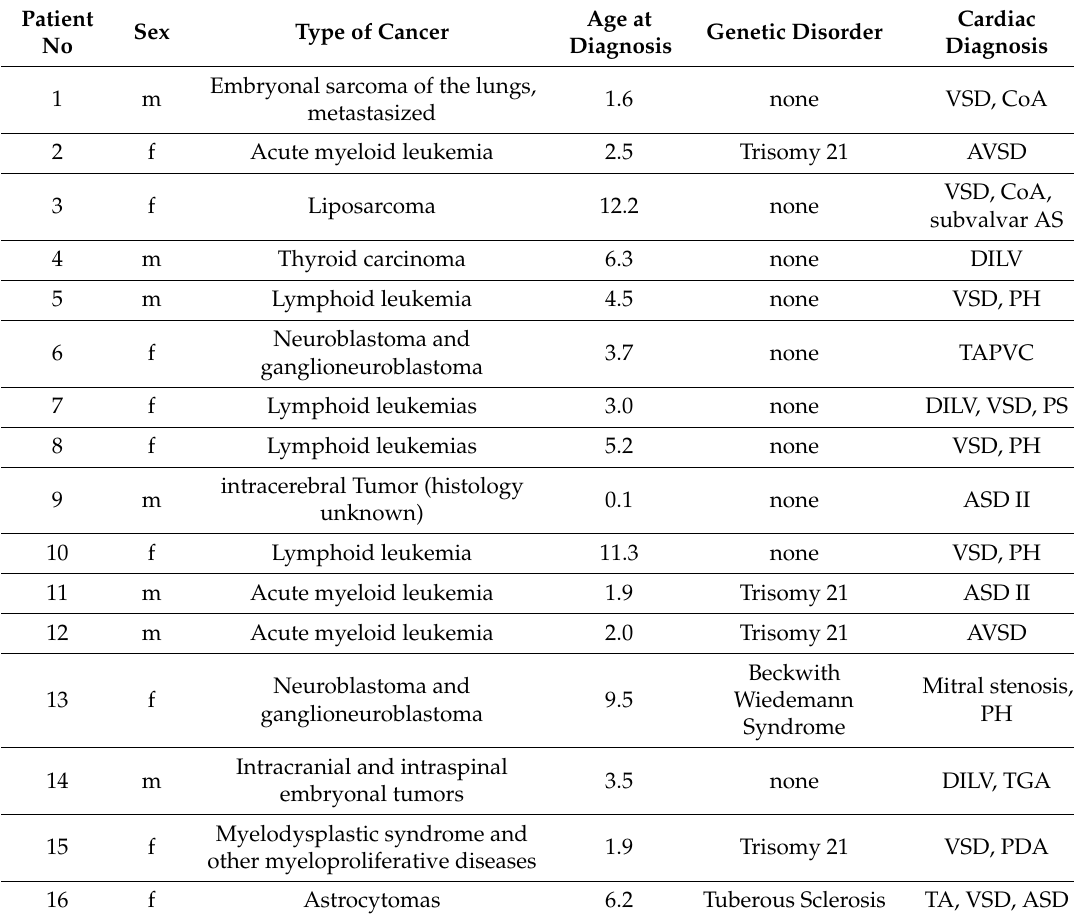
Table 1. Patient characteristics of the 16 patients with newly diagnosed malignant tumors after having undergone cardiac catherization in the first year of life. Given are type of cancer, age at diagnosis, and concomitant genetic